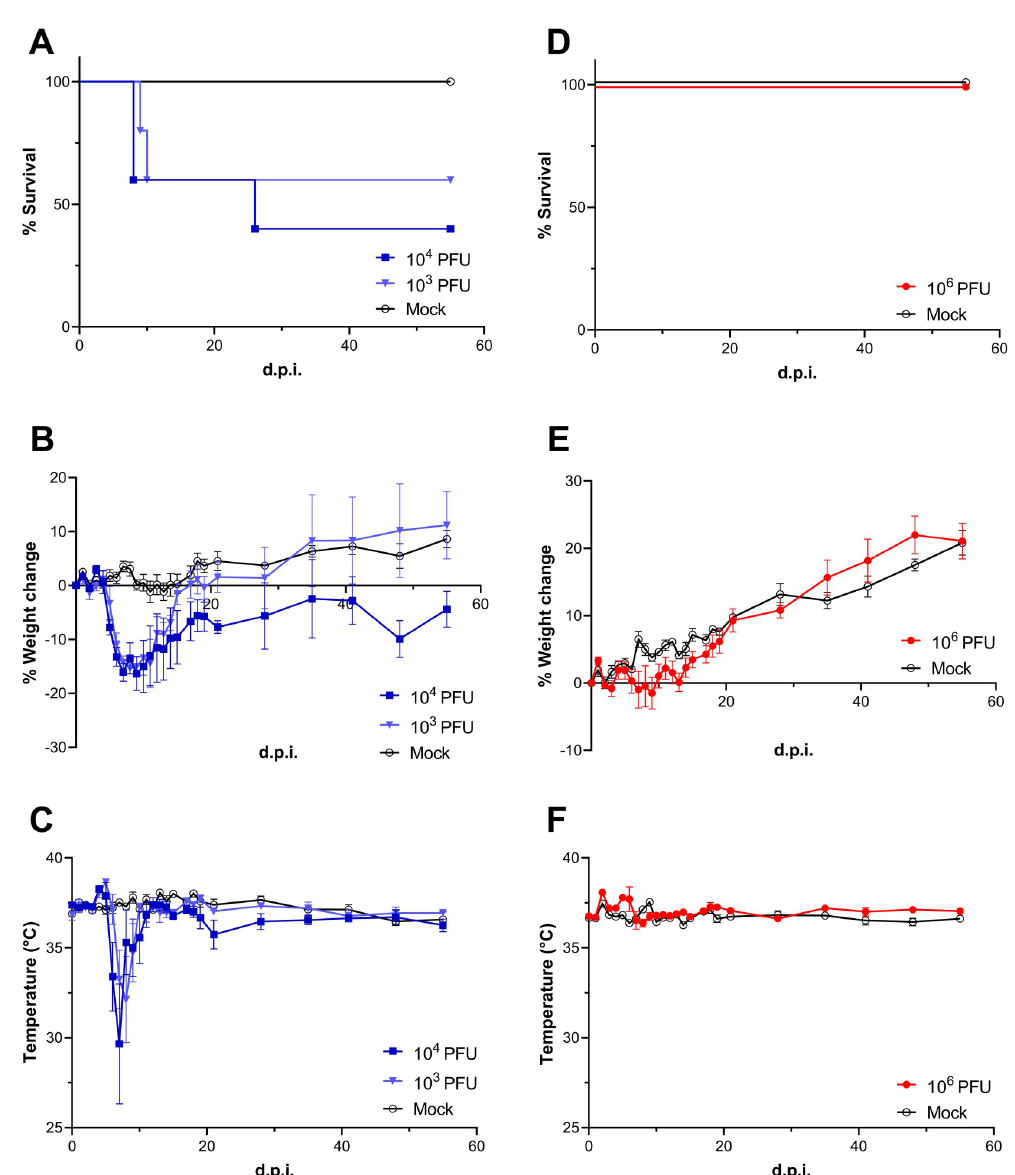
Fig 1. Pathogenicity of LASV in Stat1-KO and WT mice. Survival rate (A and D) , body weigh change (B and E) , and body temperature (C and F) of Stat1-KO (A-C) or WT mice (D-F) were plotted, respectively. Stat1-KO mice were inoculated 10 4 or 10 3 PFU of LASV (n = 10) and WT mice were inoculated 10 6 PFU of LASV (n = 5). PBS was inoculated as a mock control into Stat1-KO (n = 10) or WT mice (n = 5). Means and standard error of mean (SEM) were shown (B, C, E, and F) .